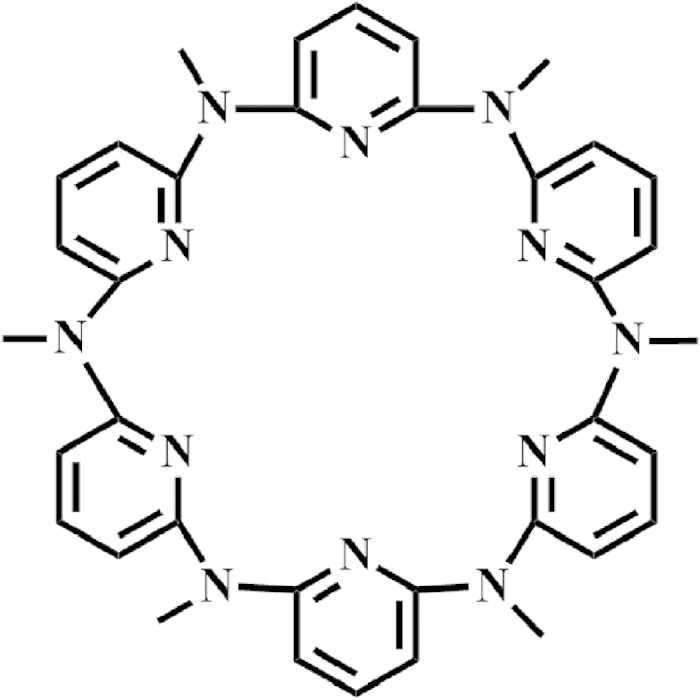
Structure of MACP6.